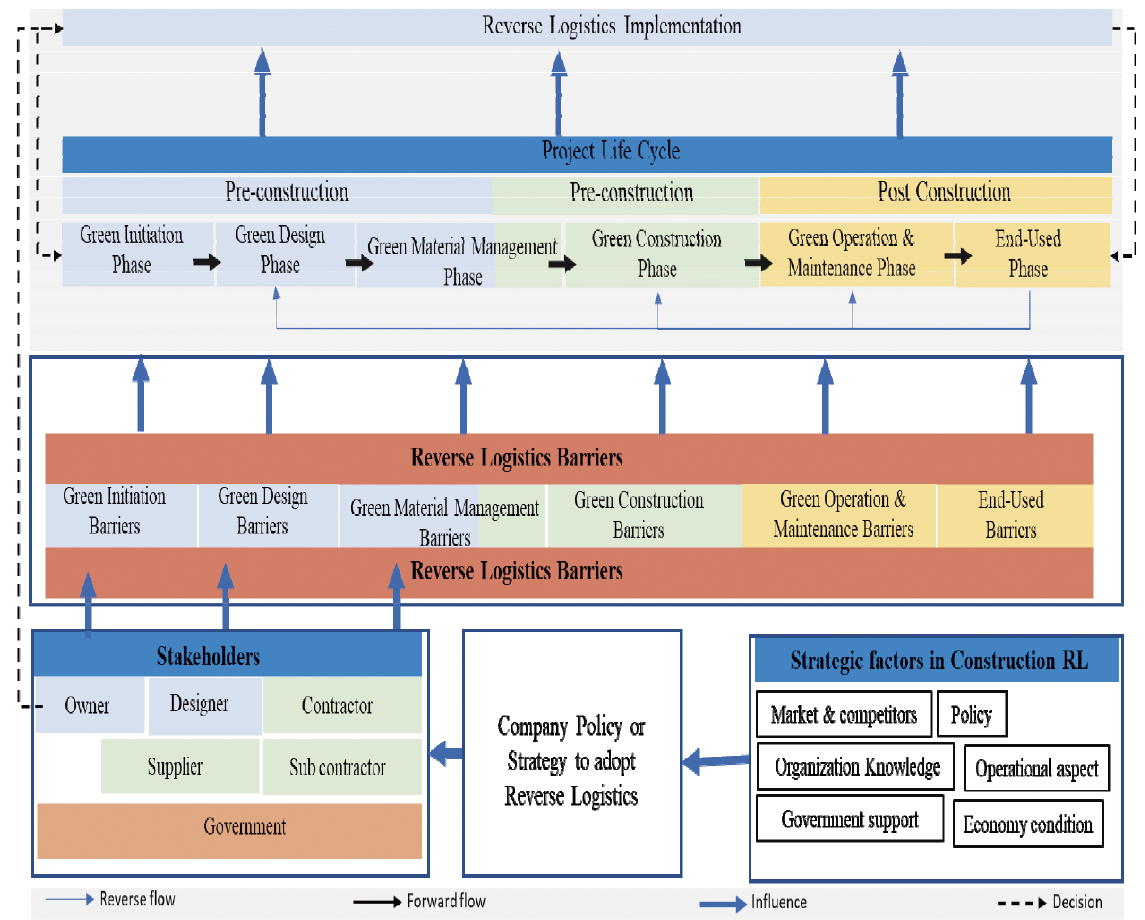
Figure 3. The Relationship between RL Implementation, PLC, Stakeholders &RL Functional